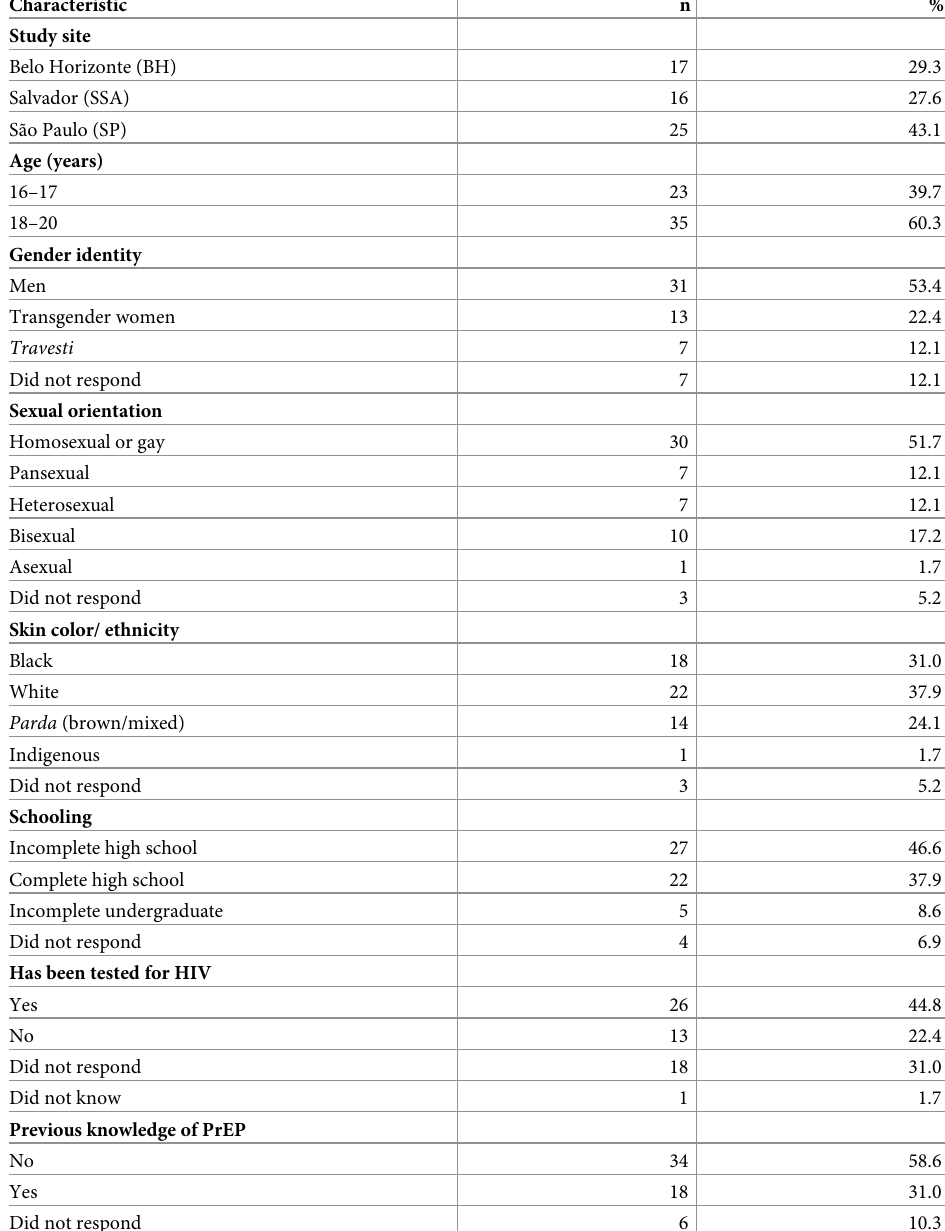
Table 1. Characterization of participants and their previous knowledge of PrEP. S ã o Paulo, Belo Horizonte, Salva- dor. Brazil. 2019. Characteristic n